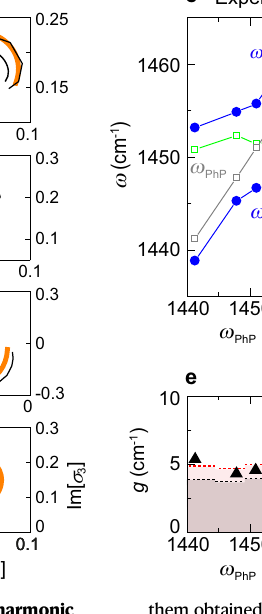
Fig. 4 | Quantitative analysis of nano-FTIR spectra by coupled harmonic them obtained by fi tting of the complex-valued experimental nano-FTIR spectra. oscillator fi tting. a Black curves show the experimental nano-FTIR amplitude d Same as panel c , but obtained by fi tting complex-valued simulated near- fi eld spectra of h-BN nanorods of length L , which are half covered with CBP molecules spectra of h-BN nanoresonators of length L = 1.2 to 0.8 μ m, which are half covered (same data as in Fig. 1d). Orange curves show fi ts obtained using the coupled by CBP molecules (the corresponding amplitude spectra are shown in Fig. 1e; the harmonic oscillator model. For better visualization, the spectrum for L = 1.0 μ m is complex-valuedspectraareshowninSupplementaryFig.3).Thetipismodeledbya scaled by a factor of 0.7. b Black curves show the complex-valued experimental point-dipole source asin Fig.3. e , f Coupling strength g obtained from the fi tting of nano-FTIRspectra, σ 3 ω ð Þ = s 3 ω ð Þ e i φ 3 ω ð Þ ,plottedinthecomplexplane.Orangecurves the experimental and simulated near- fi eld spectra, respectively. Black and red show fi tsobtainedusingthecoupledharmonicoscillatormodel. c Eigenfrequencies dashed horizontal lines indicate the transition from weak (WC) to strong (SC) ω ω coupling de fi ned by g = | γ PhP + γ CBP | / 4 ref. 32 and g = | γ PhP + γ CBP |/3.23 (see ± of the hybrid modes, the nanoresonators´ bare eigenfrequencies PhP (gray squares),andbaremolecularvibrationaleigenfrequency ω CBP (greensquares),allof discussion below),